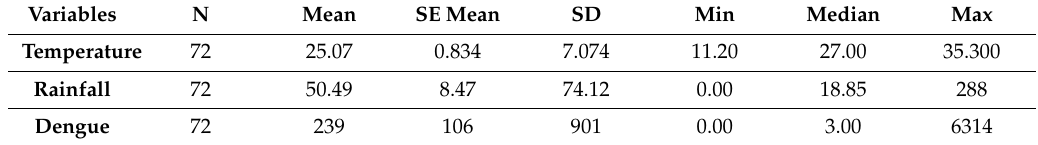
Table 1. Descriptive Statistics of Temperature, Rainfall, and Dengue cases of Lahore from 2007–2012. Variables N